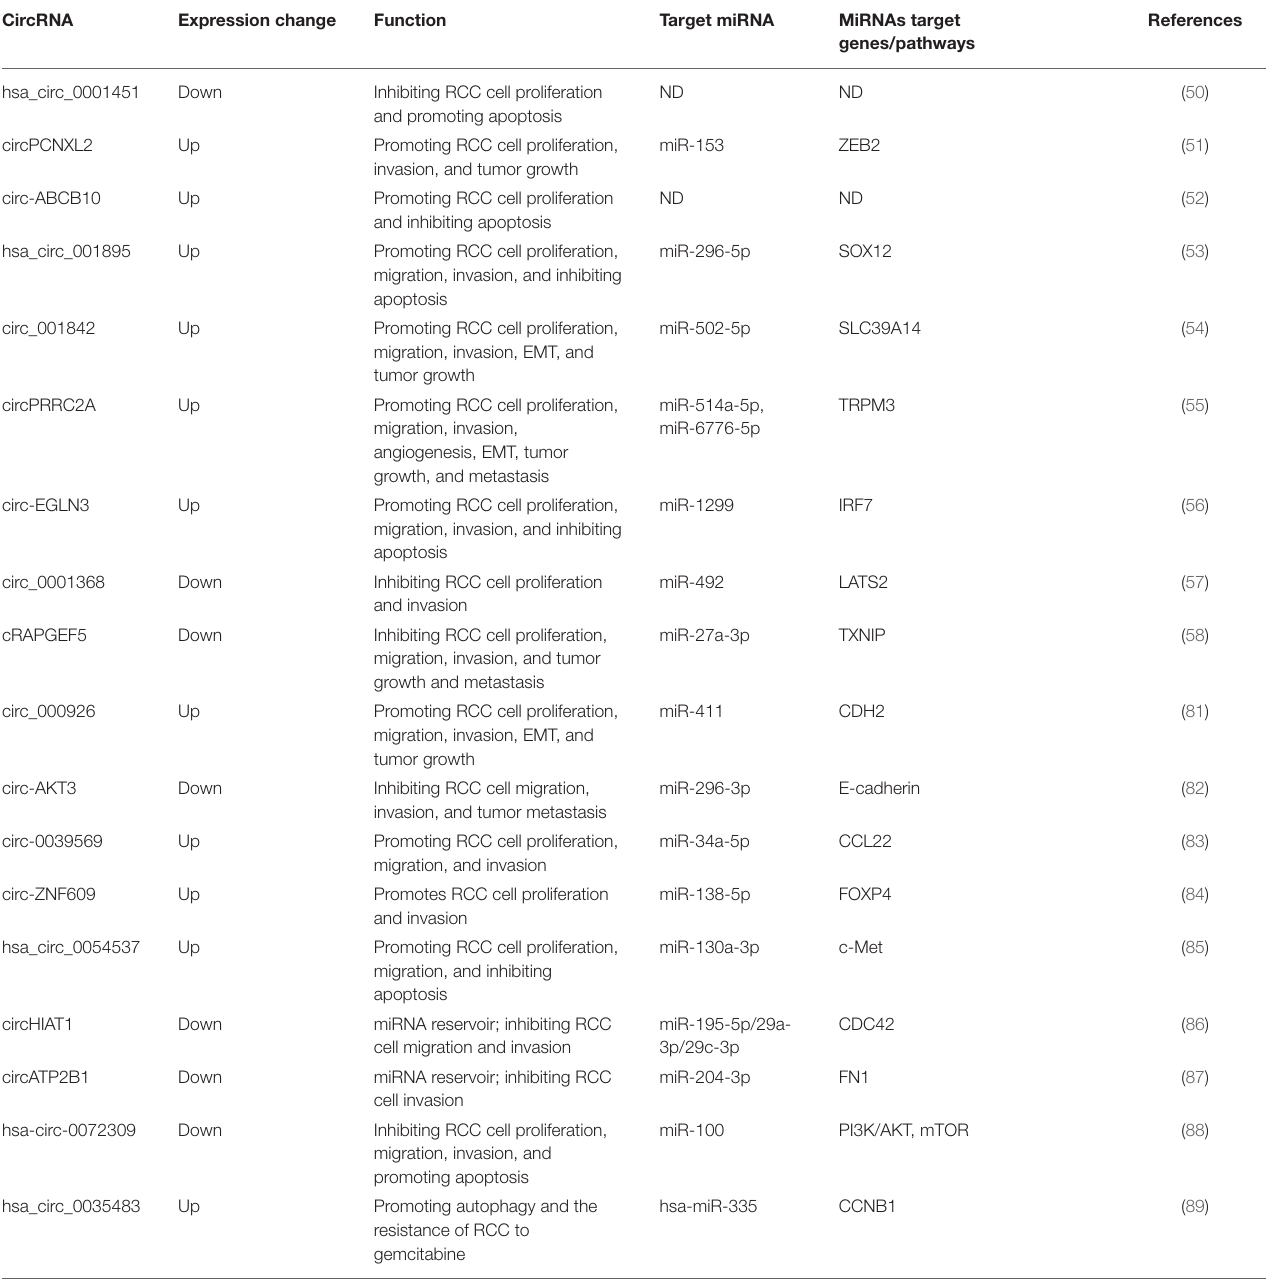
TABLE 2 | Summary of candidate circRNAs as therapeutic targets in renal cell carcinoma (RCC).